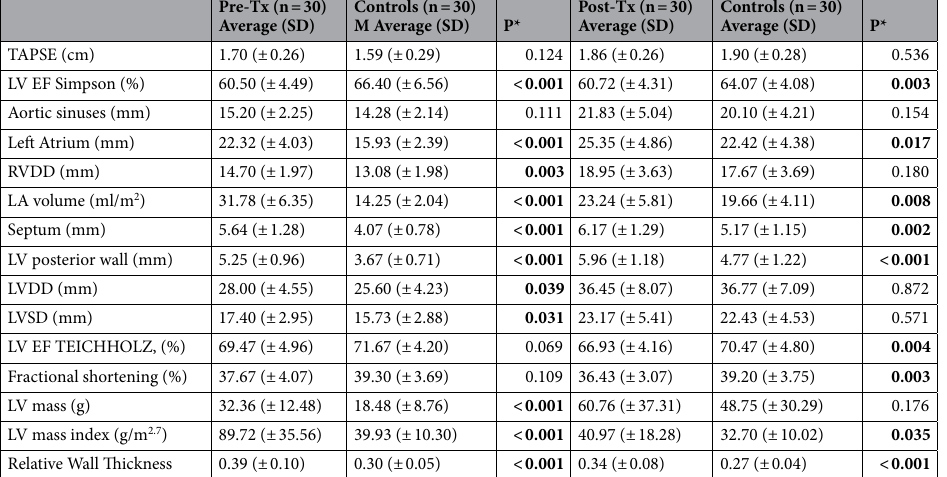
Table 2. Two-D and M-mode Echocardiogram. Statistical significance p < 0.05. TAPSE, Tricuspid Annular Plane Systolic; LV EF, LV ejection fraction; RVDD, right ventricle diastolic diameter; LVDD, LV diastolic diameter; LVSD, LV systolic diameter; *Students t-test.